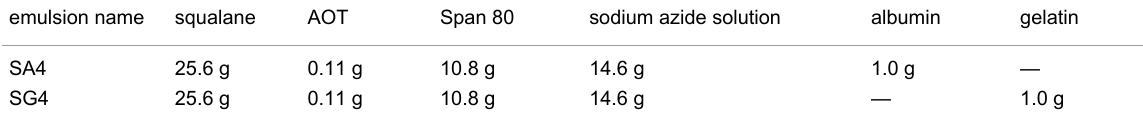
Table 4: Composition of second generation inverse emulsions.